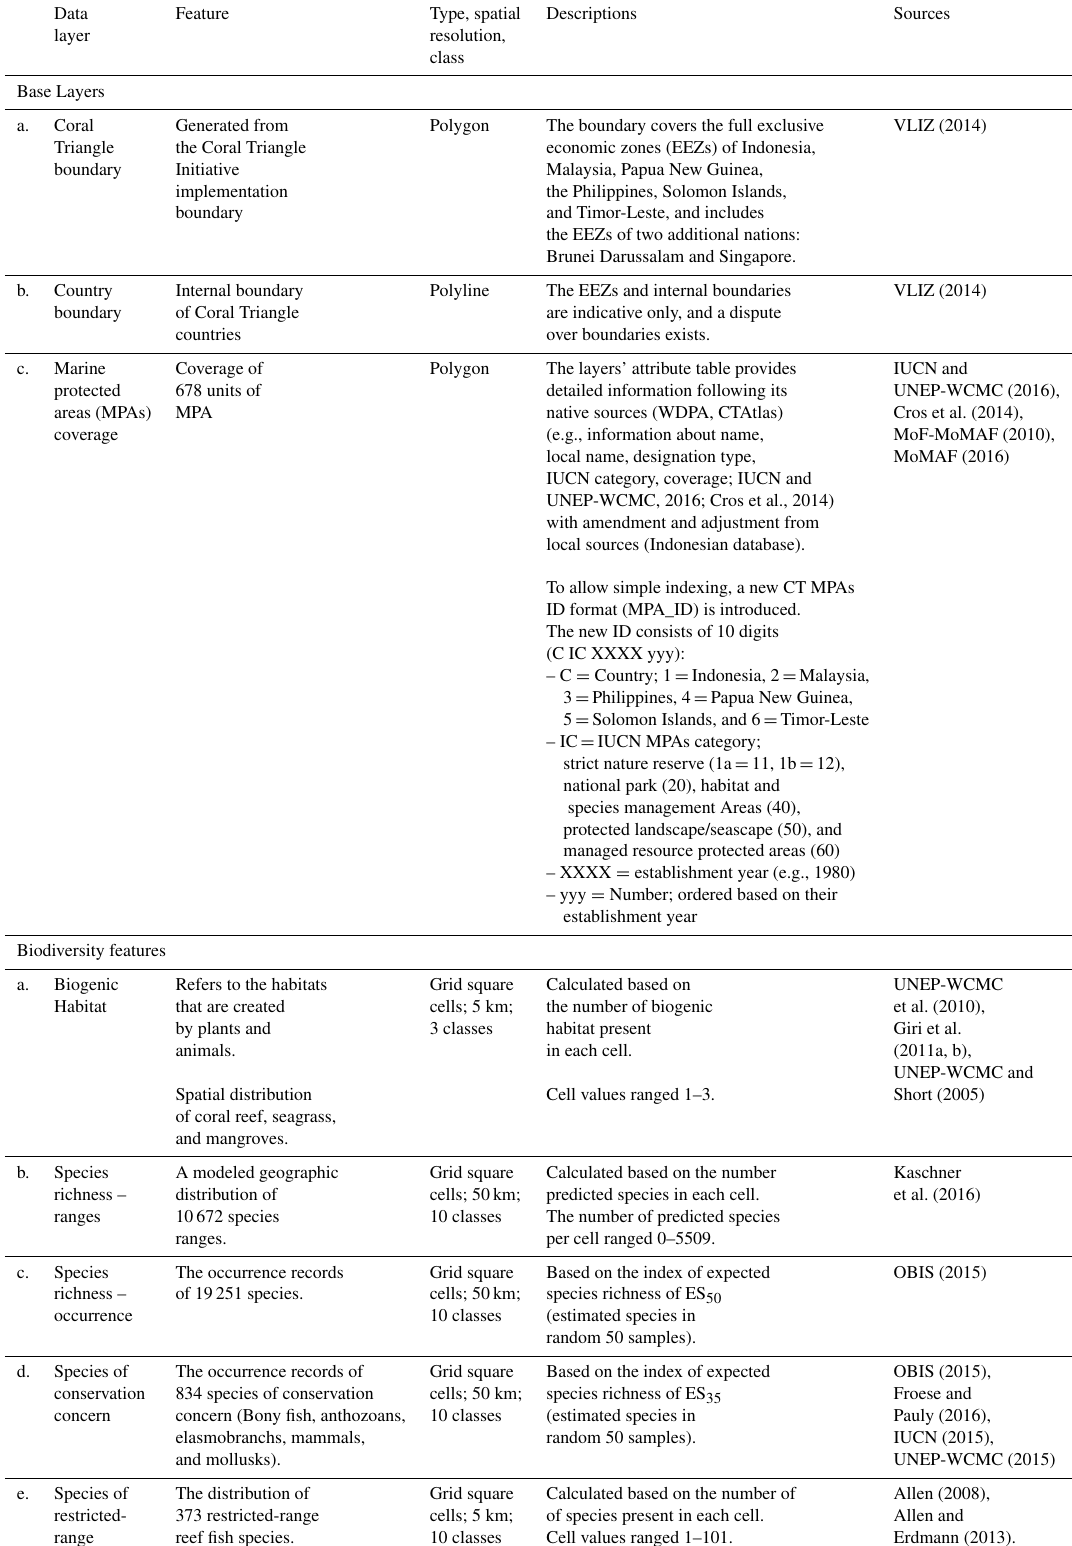
Table 1. Coral Triangle datasets